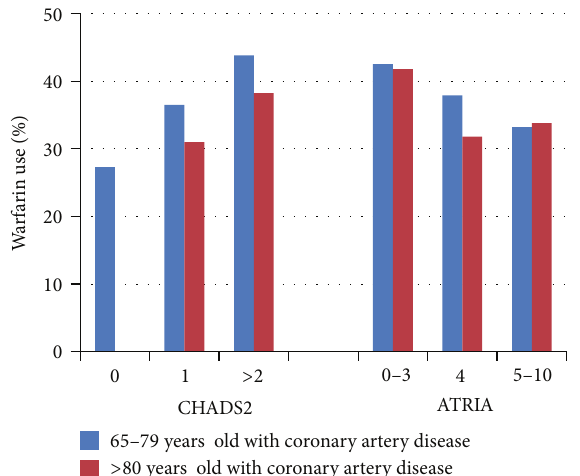
Figure2:DukeDatabank.Warfarinuseatdischargeamongpatients with coronary artery disease according to CHADS2 (stroke) and ATRIA (bleeding) scores in patients 65 to 79 versus ≥ 80 years of age